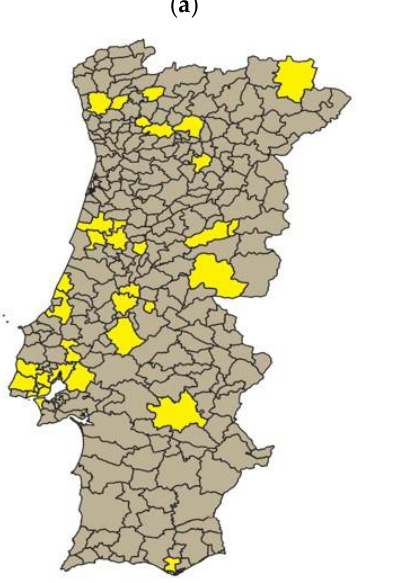
Figure 2. Cell grid representing the Portuguese mainland where termite observation reports existed before 1970. Each cell was defined according to termite presence (green) or absence (white) or to its being outside the Portuguese mainland territory (black).